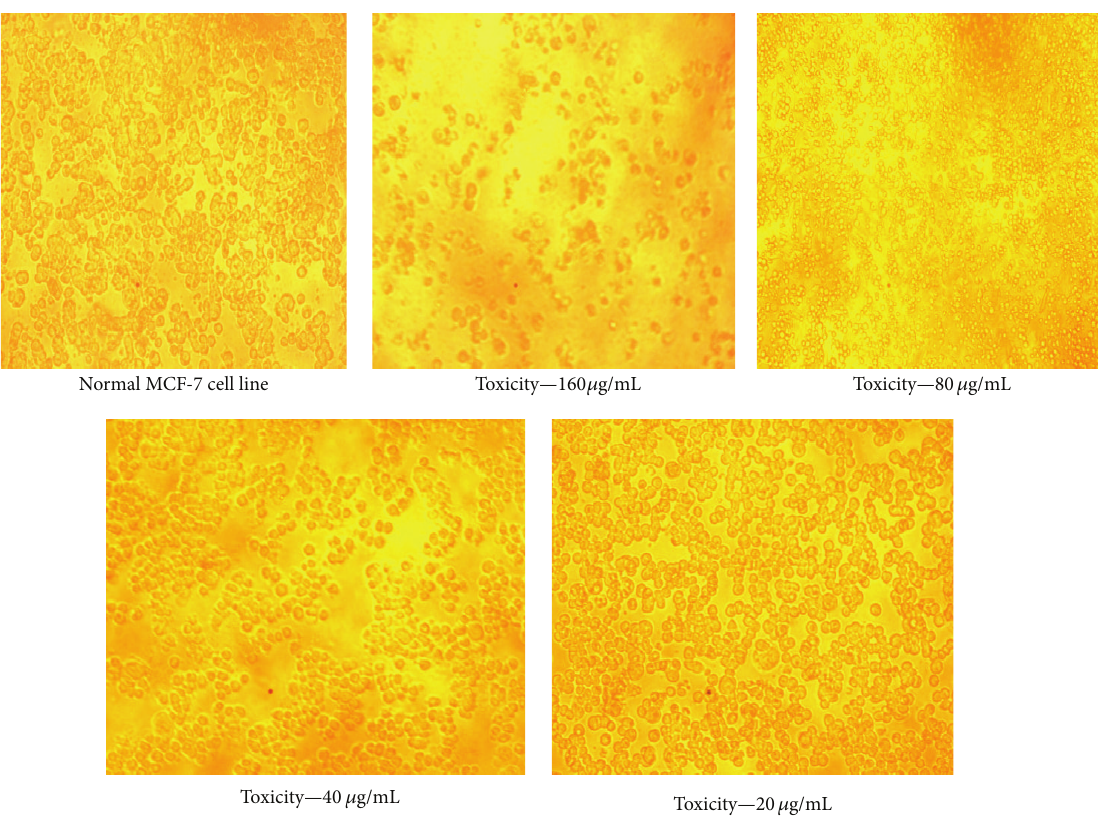
Figure 4: Anticancer effect of 70% ethanolic extract of Cissus quadrangularis on MCF-7 cell line at different